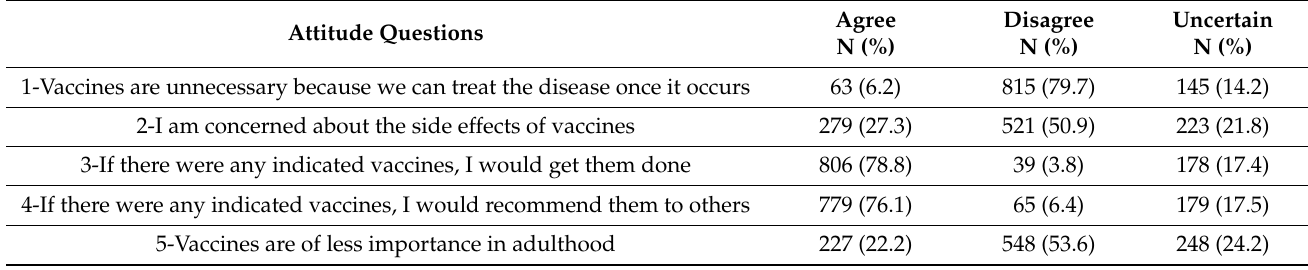
Table 4. The attitude of subjects toward vaccination. LAUMCRH. January 2020–January 2021.